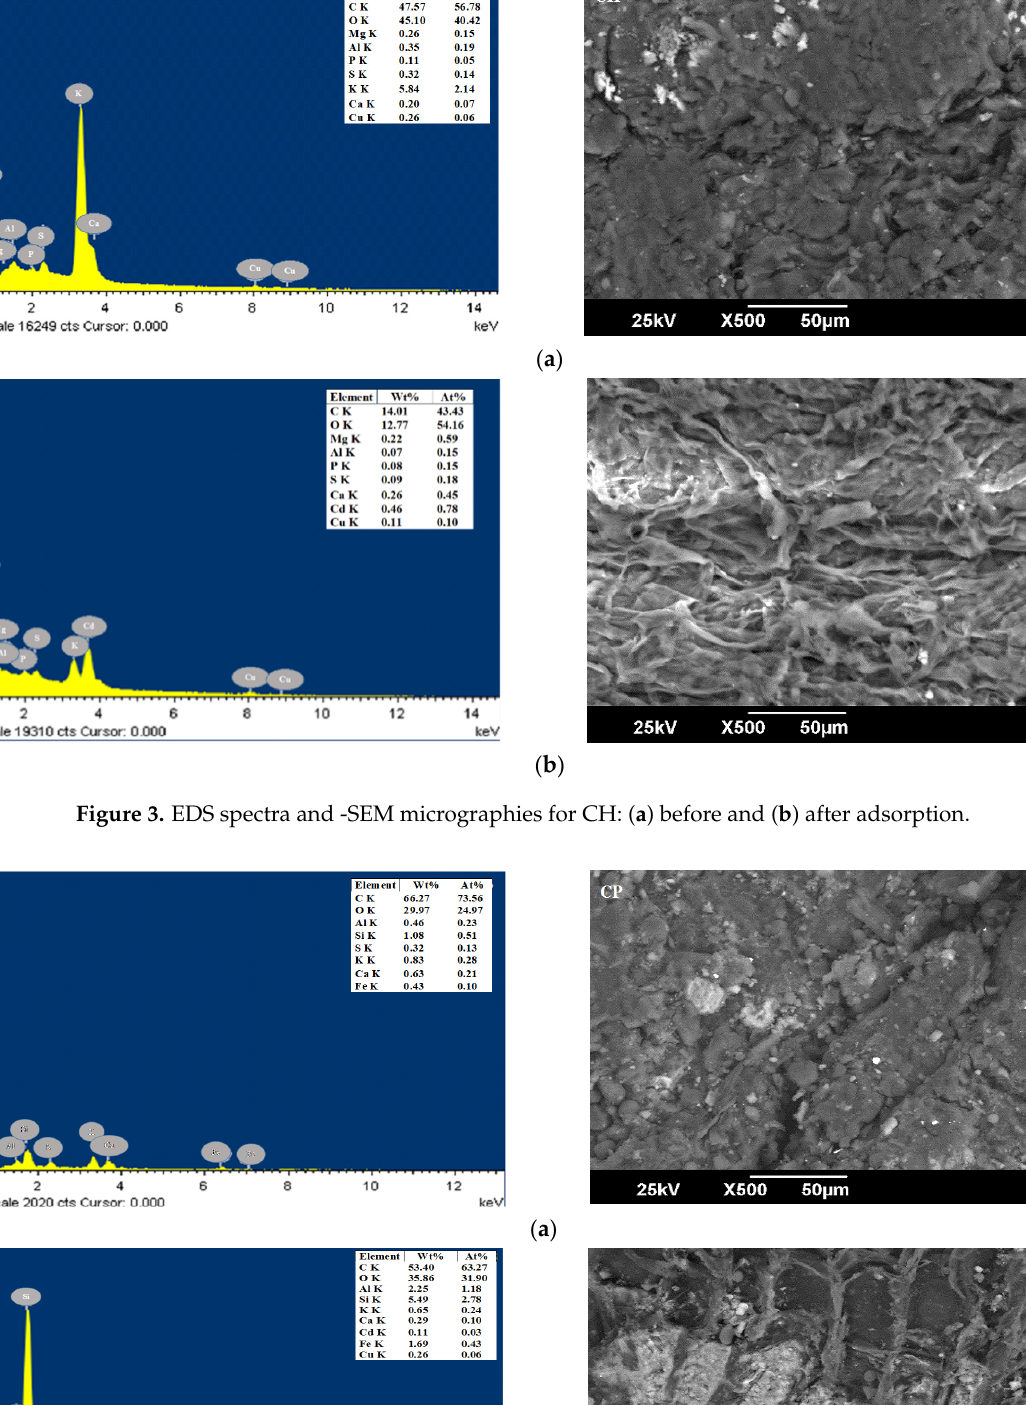
Figure 2. EDS spectra and -SEM micrographies for r OPB: ( a ) before and ( b ) after adsorption.